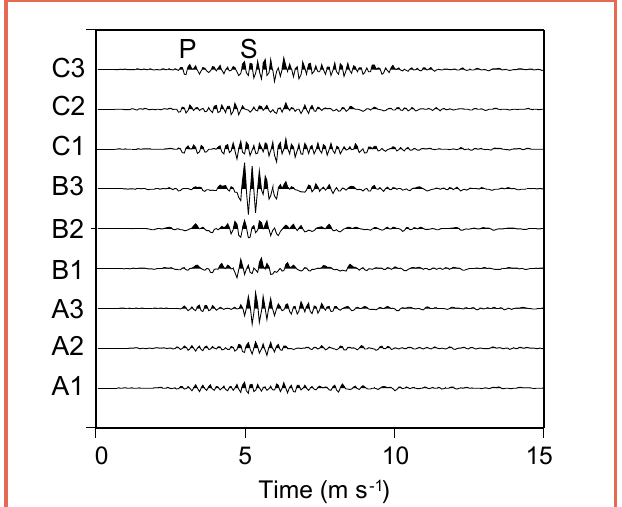
Figure 5. Correlated 3-component recordings of the direct compressional (P) and shear (S) waves at receiver 24 (see R24 in Fig. 3). The source-receiver offset is 17 meters. A – vertical component traces, B – horizontal component traces, C – radial component traces; 1 – sources are in phase, 2 – seismic wave field directed towards Richtstrecke, 3 – seismic wave field directed towards Wilhelm Stehender Süd.